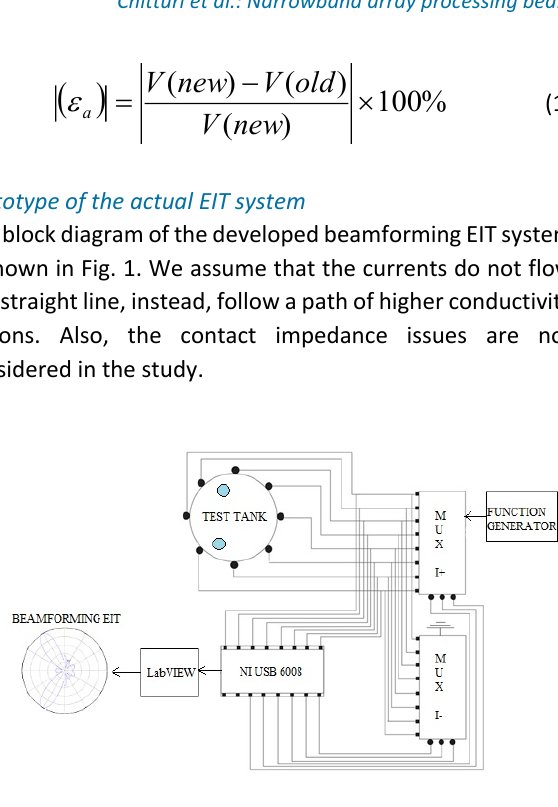
Fig. 1: Complete block diagram of the developed beamforming EIT system. The input current is injected into the electrodes adjacently through the multiplexer circuit. The individual voltages are measured by NI USB 6008 from the non-current carrying electrodes. The beamforming algorithm displays the location of the test objects in the form of two beams.